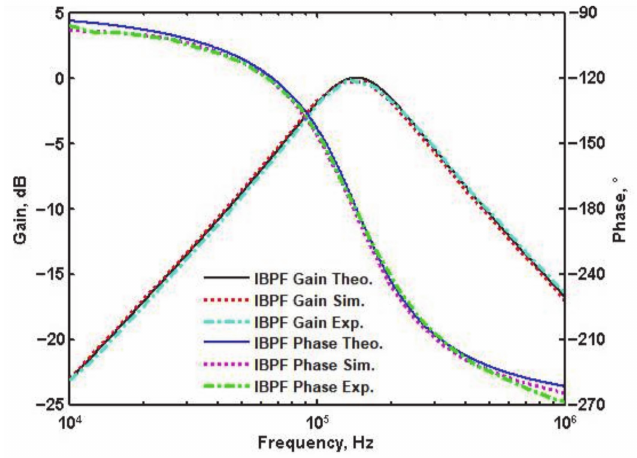
Figure 11. Comparison of IBPF experimental response, simulated response, and theoretical response in Part II.